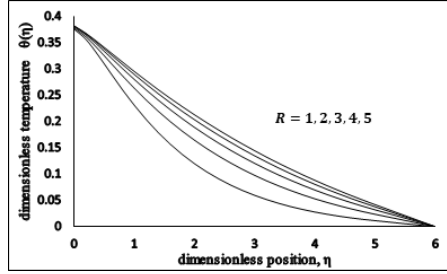
Figure 10. Dimensionless Temperature vs R